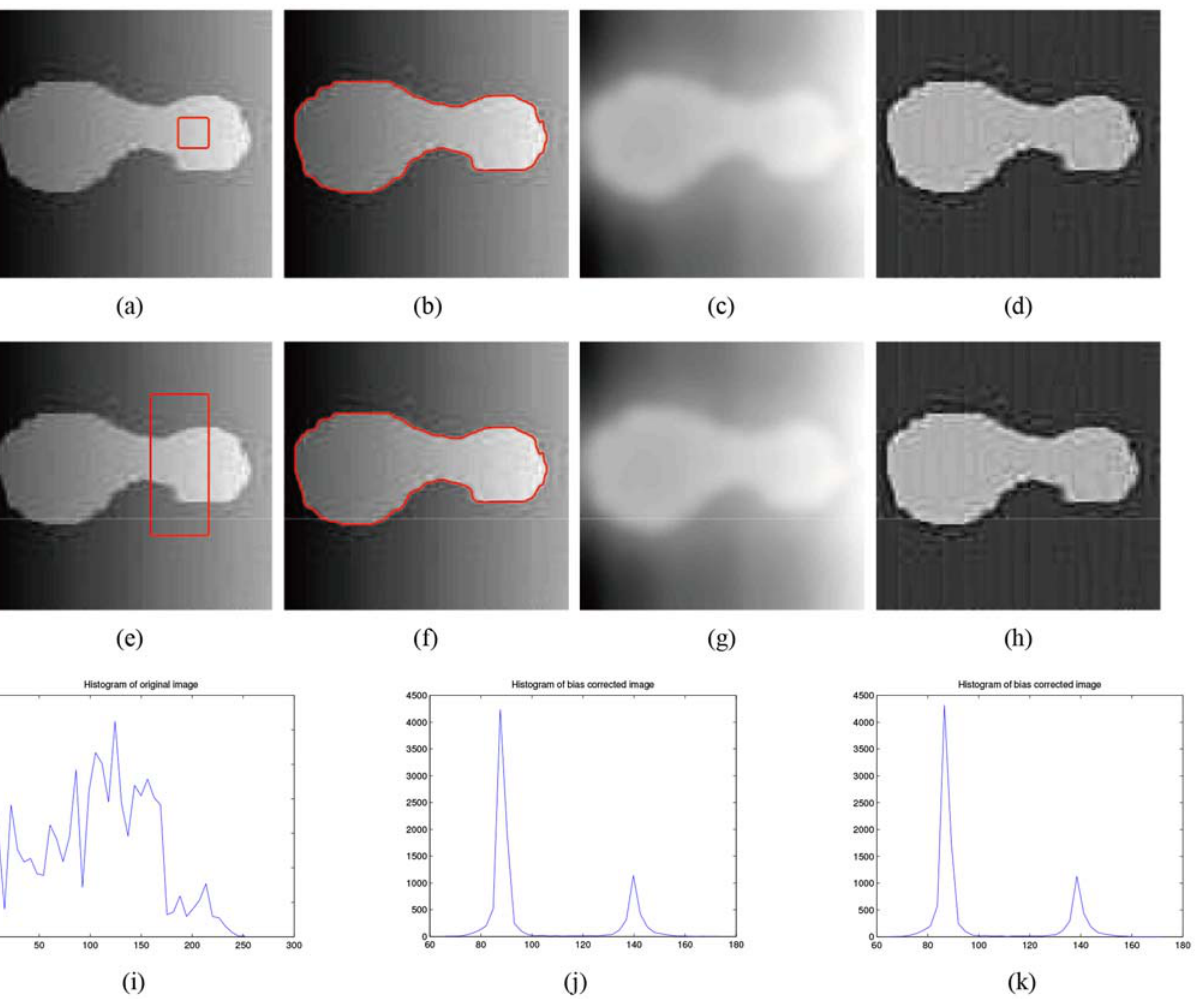
Fig 5. Experimental results of our model. (a), (e) The original image with red initial contours. (b), (f) The final segmentation results of our model. (c), (g) The estimation of the bias field. (d), (h) The corrected image. (i) The histogram of the original image. (j) The histogram of the corrected image with initial contour (a). (k) The histogram of the corrected image with initial contour